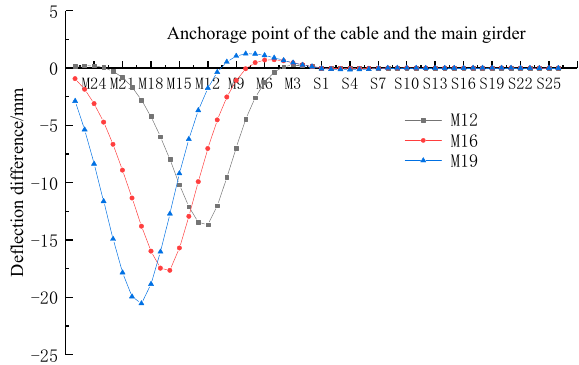
Figure 16. The de fl ection di ff erence distribution curve of the girder before and after the cable damaged (50%) When the overall temperature dropped 15 °C.